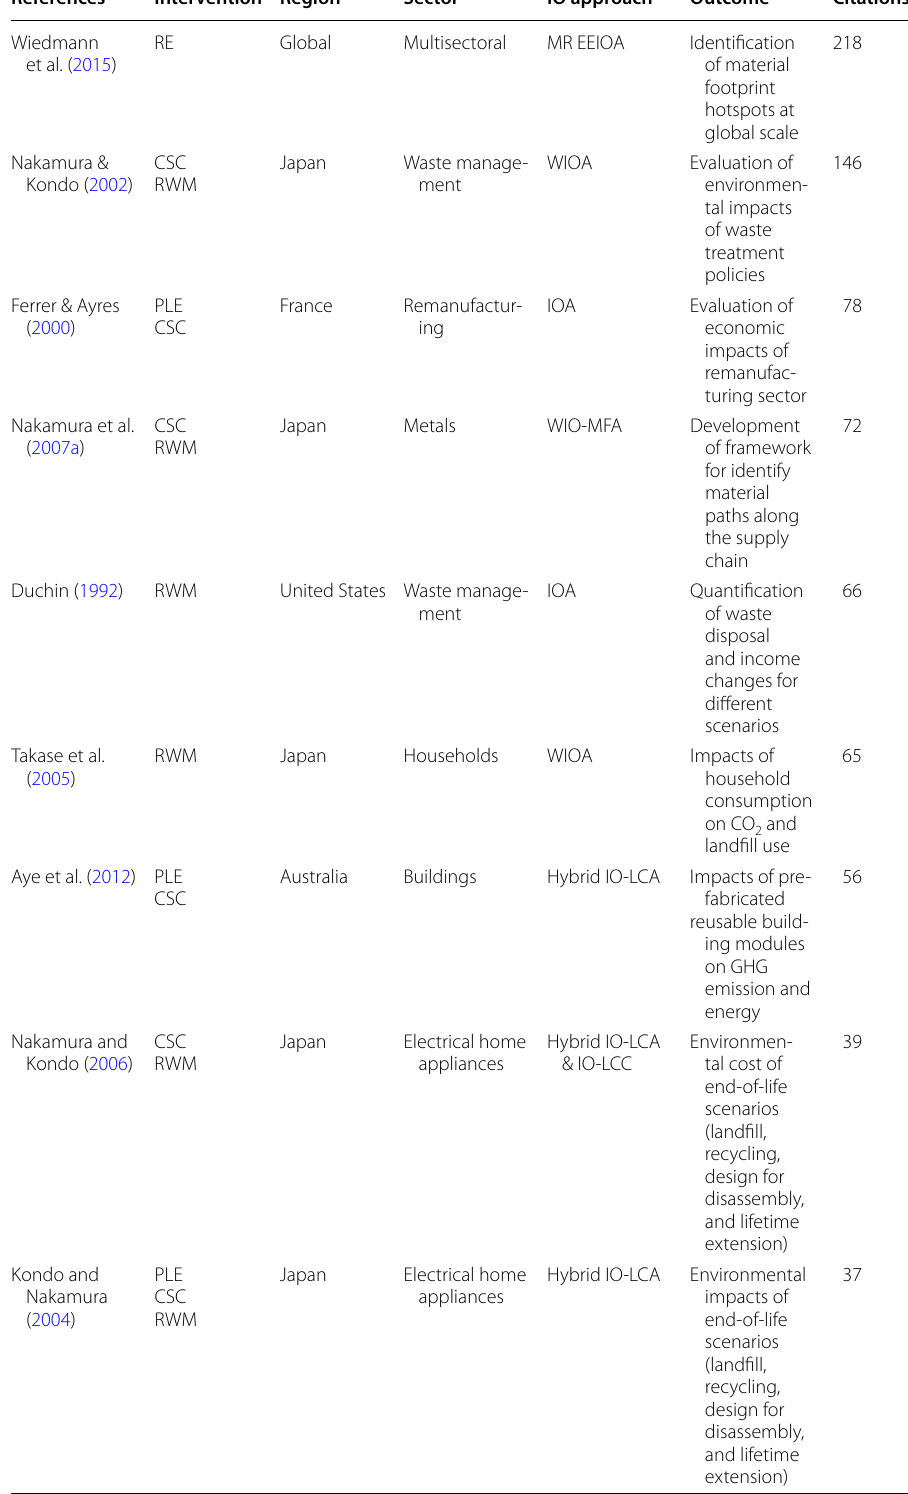
Table 2 Overview of top-10 most cited articles related to the assessment of circularity interventions (status on 11 June